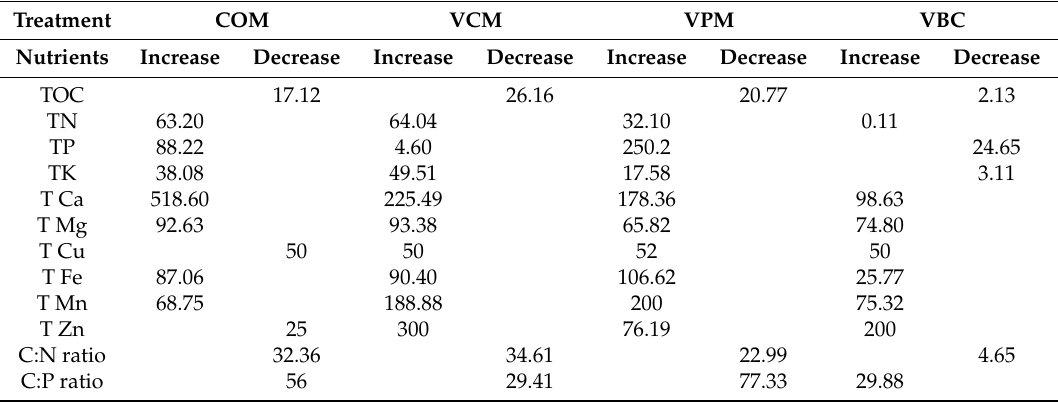
Table 2. Nutrients increase or decrease (%) in all